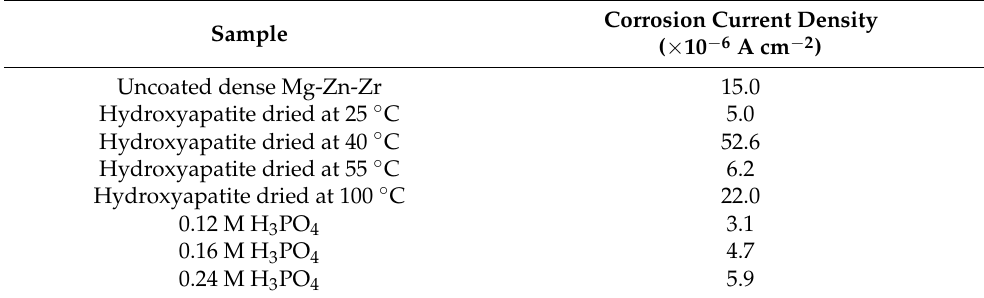
Figure 6. Potentiodynamic polarisation of dense Mg-Zn-Zr samples coated with ( a ) hydroxyapatite at different drying temperatures and ( b ) phosphoric conversion coating with different initial concentrations of phosphoric acid. The polarisations curved were obtained after 30 min immersion in 0.1 M NaCl at a scan rate of 1 mV s − 1 . Table 2. Corrosion current of uncoated 2-dimensional (dense) Mg-Zn-Zr, HA-coated dense Mg-Zn- Zr, and phosphate-coated dense Mg-Zn-Zr alloy, obtained from Tafel extrapolation of respective potentiodynamic polarisation curve in 0.1 M